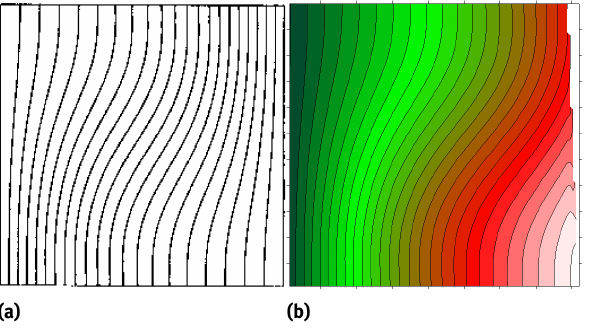
Figure 3: The comparison of temperature distribution ((a) the benchmark, (b) the results of the given paper) at Re = 10 3 .